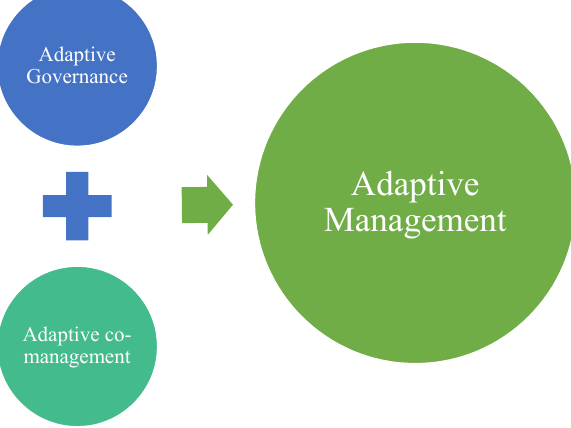
Figure 1. Adaptive management relies on adaptive governance and co ‐ management.